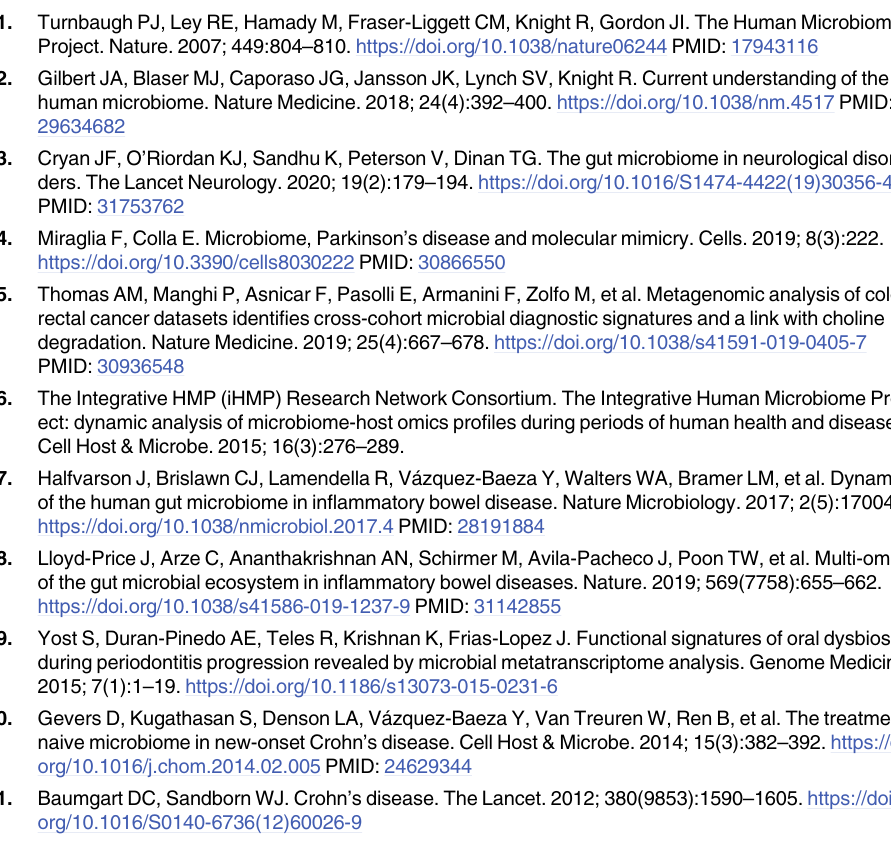
S4 Table. KEGG pathways that were significantly disrupted along at least one of the mod- eled progression